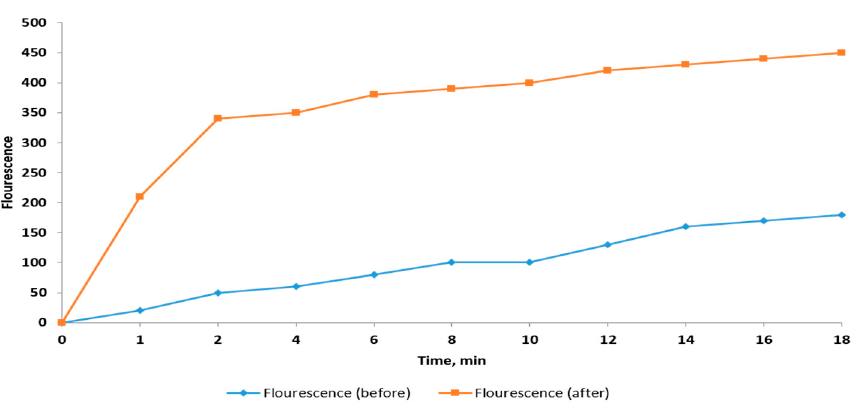
Figure 5. Representative example of the change in the outer membrane permeability of K. pneumoniae isolates before and after treatment with C. thouarsii extract (16 µg/mL).